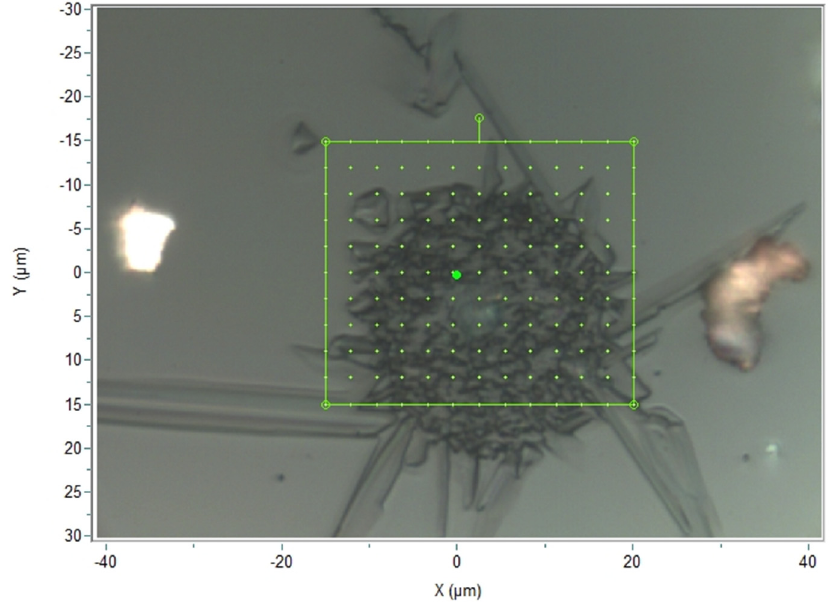
Figure 6. Measurement points for the 3D Raman cartography.